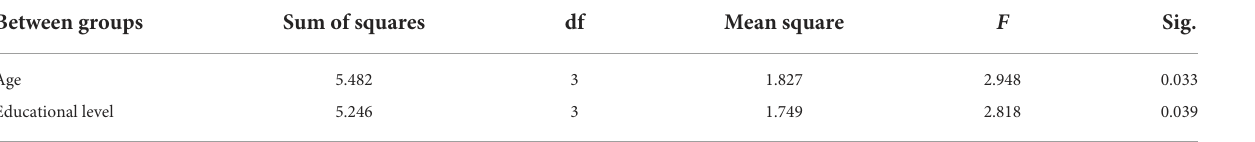
TABLE 5 ANOVA, F -test for age, and educational level variables. Between groups Sum of squares df Mean square F Sig. Age 5.482 Educational